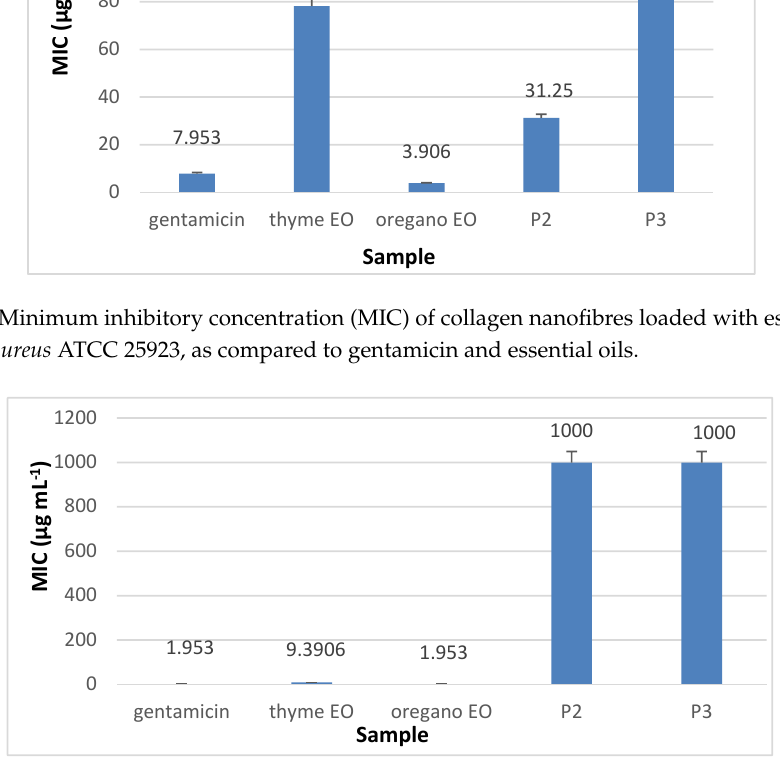
Figure 11. MIC of collagen nanofibres loaded with essential oils against E. coli ATCC 25922, as compared to gentamicin and essential oils.